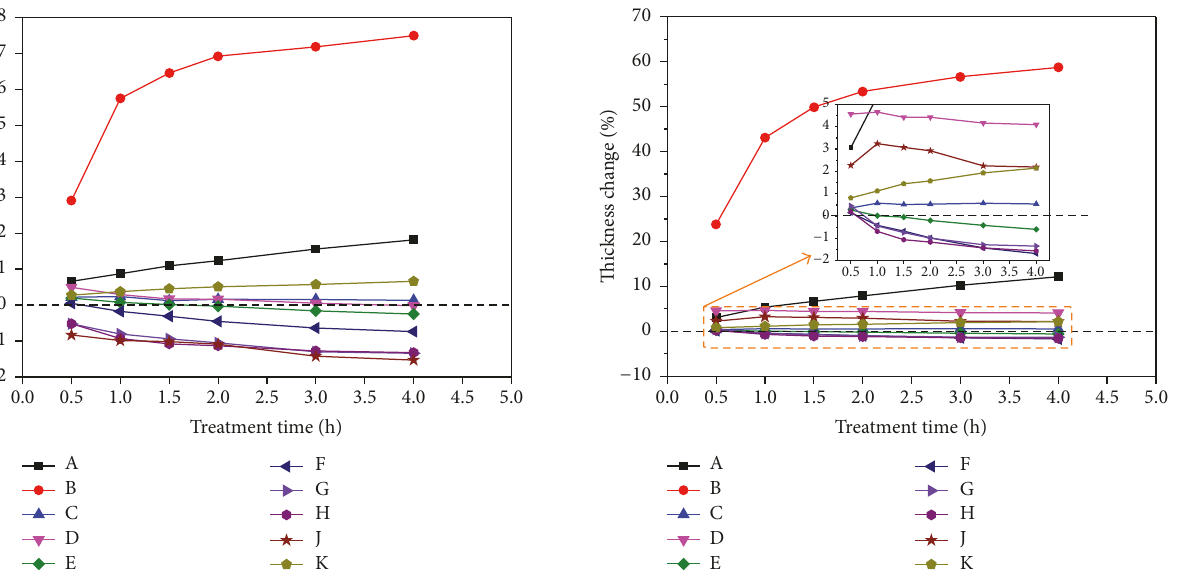
Figure 4: Width percentage change of bamboo scrimbers during 4- hour treatments. A, B, and K: water immersion at 63 ∘ C, 100 ∘ C, and 25 ∘ C; C and D: oil immersion at 100 ∘ C and 150 ∘ C; E, F, and G: air drying at 63 ∘ C, 100 ∘ C, and 150 ∘ C; H and J: infrared drying at 100 ∘ C and 150 ∘ C.